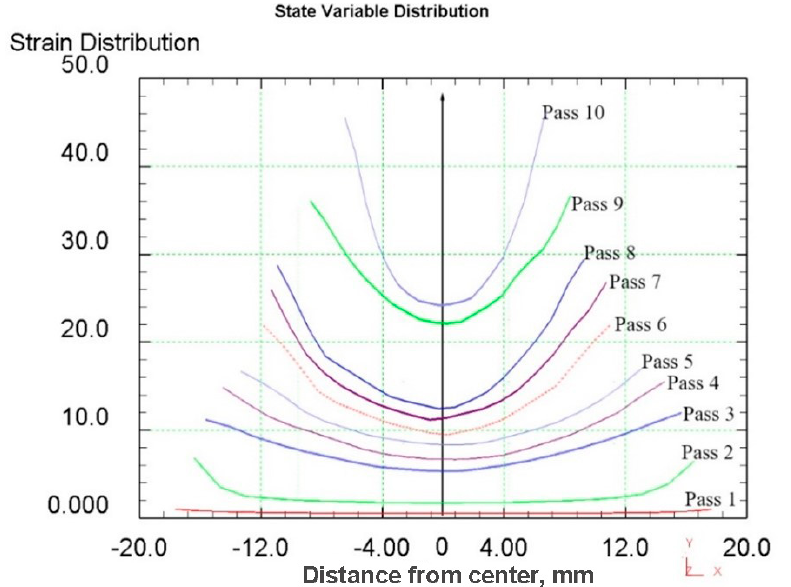
Figure 6. Graphs of equivalent strain distribution over the workpieces cross-section by all treatment